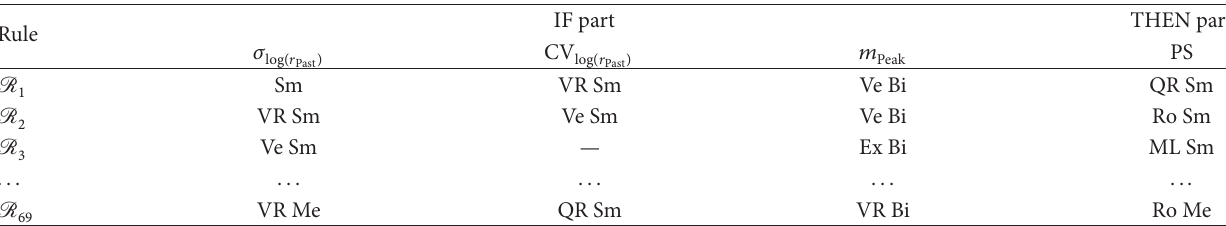
Table 8: Examples of fuzzy rules found by the fuzzy GUHA